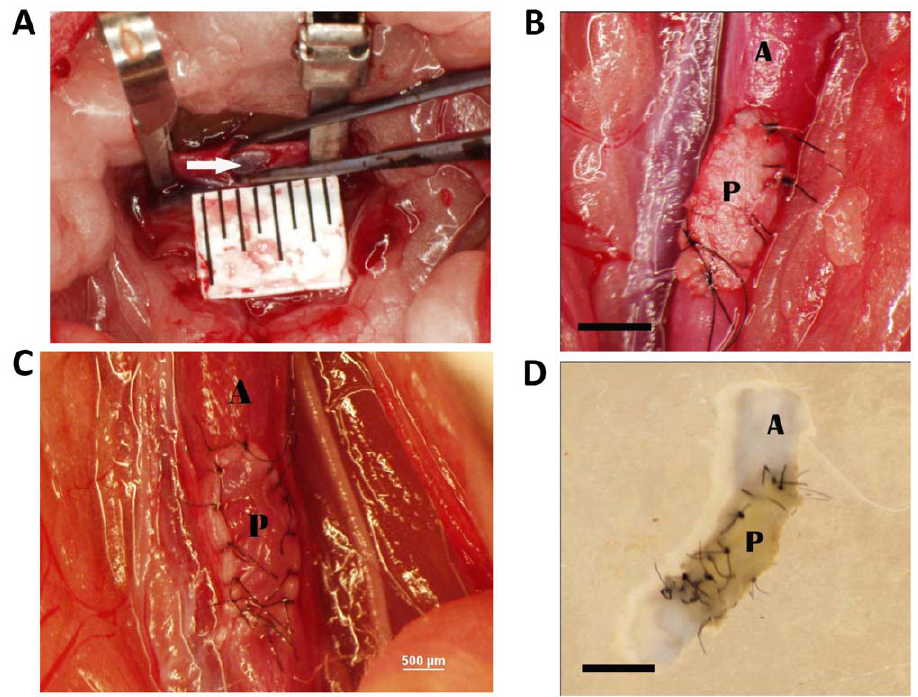
Figure 1. Photomicrographs of the implanted pericardial patch. A ) The rat aorta after arteriotomy and prior to patch placement; the white arrow shows the glistening intima on the posterior wall; ruler markings are 1mm. Scale bar, 1000 microns. B ) Completed bovine patch closure. Scale bar, 1000 microns. C ) Completed porcine patch closure. Scale bar, 500 microns. D ) Explanted aortic segment containing patch after harvesting and flushing. Scale bar, 1000 microns. In each graph, A =aorta; P =pericardial patch.